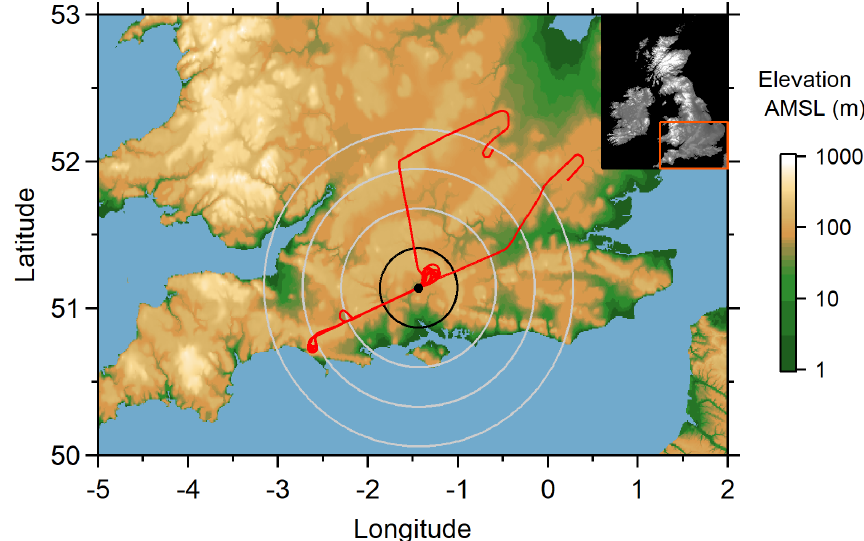
Figure 1. NXPol radar location at the Chilbolton Atmospheric Observatory. Circles with their centre on the radar position represent a 30, 60, 90 and 120km range. Credit: USGS (2006).